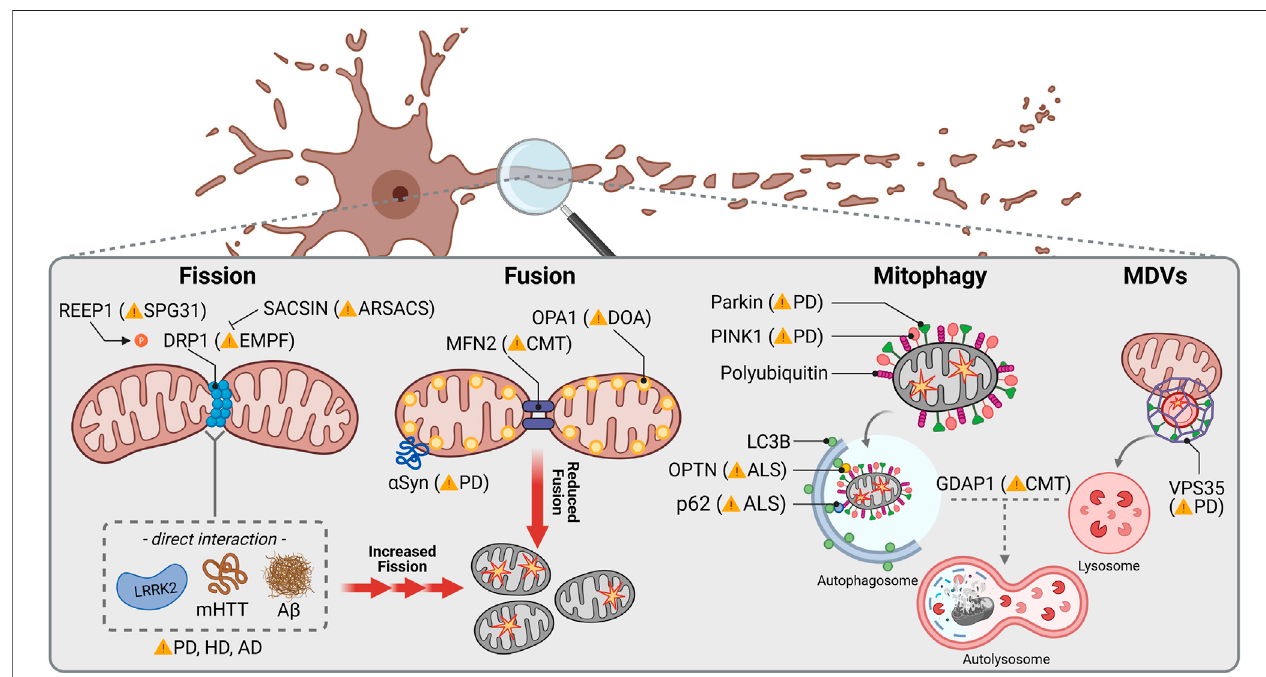
FIGURE 2 | Mitochondrial dynamics in common and rare neurodegenerative diseases. Mitochondrial fi ssion is orchestrated by DRP1, which mutations have been linkedtoautosomaldominantencephalopathyandneonatallethalitycausedbydefectivemitochondrialandperoxisomal fi ssion.MutationsinREEP1areassociatedwith autosomaldominantSpasticParaplegiaType31(SPG31)duetohyperphosphorylationofDRP1causingincreasedmitochondrial fi ssion.Incontrast, SACSIN mutations leadtoautosomalrecessiveSpasticAtaxia ofCharlevoix-Saguenay(ARSACS)underlying reduced DRP1recruitmenttomitochondrialmembranesand decreased fi ssion. PD, HD and AD associated proteins LRKK2, mHTT and A β , respectively, have been reported to directly interact with DRP1 stimulating mitochondrial fi ssion. Mitochondrial fusion is regulated by the OMM protein MFN2 and the inner mitochondrial membrane protein OPA1, whose mutations cause autosomal dominant Charcot-Marie-Tooth disease (CMT) and Optic atrophy (DOA), respectively. α Syn interacts with TOM20 which is accompanied with a lower mitochondrial fusion rate. Speci fi cremoval of mitochondria through mitophagy in neurons is controlled by PINK1 and Parkin, mutations of both being related to early juvenile recessive PD. PINK1 signalizes depolarized mitochondria by inducing recruitment of Parkin and starting a signaling cascade to remove defective mitochondria through autophagosome- lysosome degradation. Other receptors linked to recessive forms of ALS are the mitophagy speci fi c adaptor protein OPTN and the general autophagy adaptor p62. CMT-relatedGDAP1mediatescontactsbetweenmitochondriaandlysosomesandishencethoughttobeinvolvedinmitochondrialremovalaswell.Ahigherspecialized pathway toeliminatemitochondrial fragmentsisknowntopursue themitochondrial-derived vesicles(MDVs)trail,whereVPS35,linkedtodominantformsofPD, triggers the force to generate vesicles which eventually fuse with